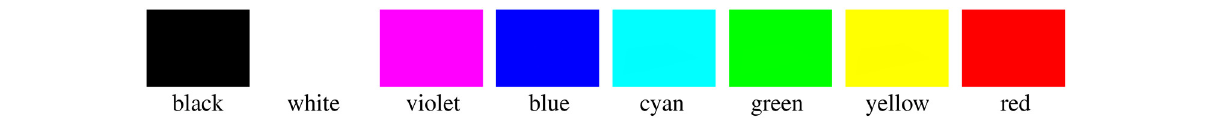
Frontiers in Neuroinformatics |